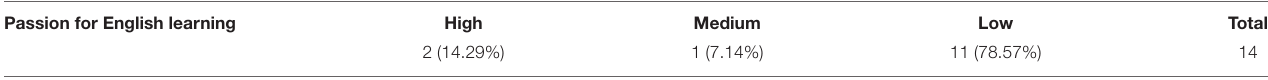
TABLE 1 | The participants’ self-scaled level of interest in English learning. Passion for English learning